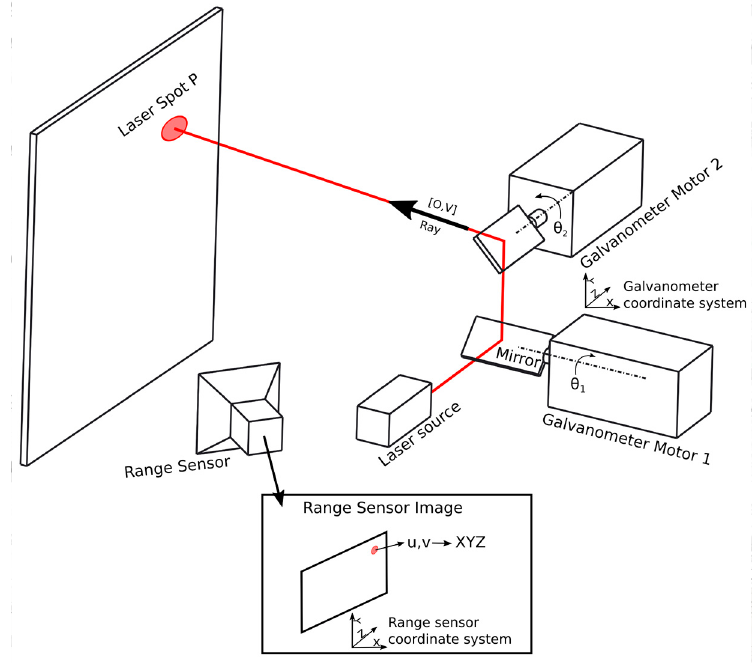
Figure 1. Schematic overview of the galvanometric mirror system and range